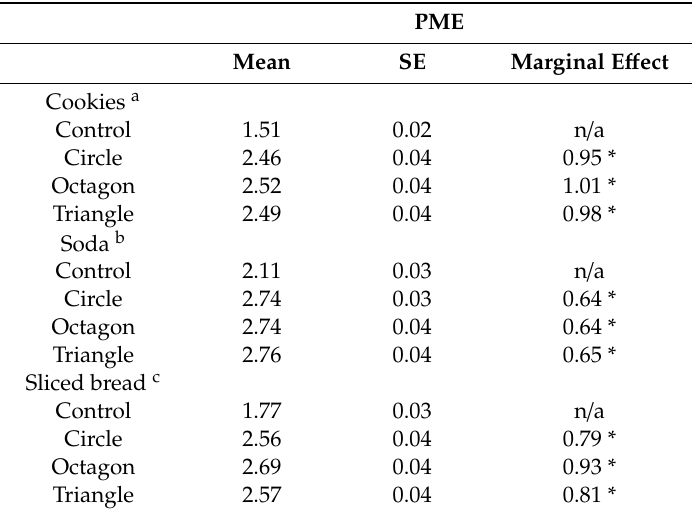
Table A6. Predicted mean perceived message e ff ectiveness and marginal e ff ect.